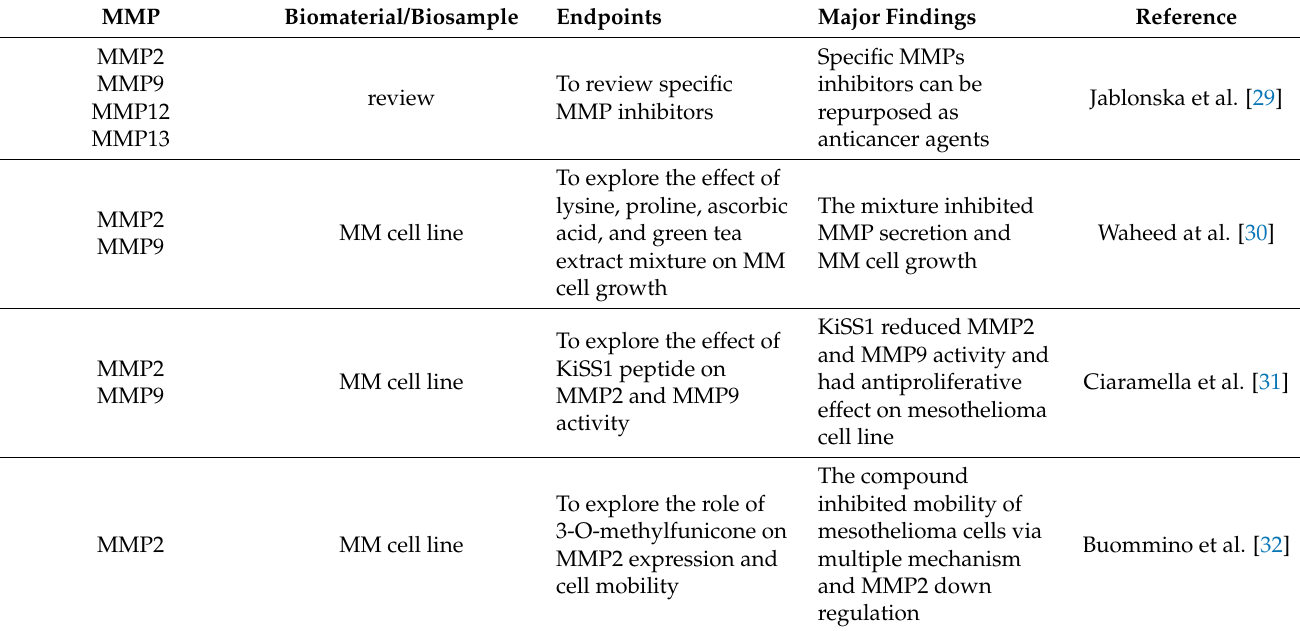
Table 3. Metalloproteinases (MMPs) as potential drug